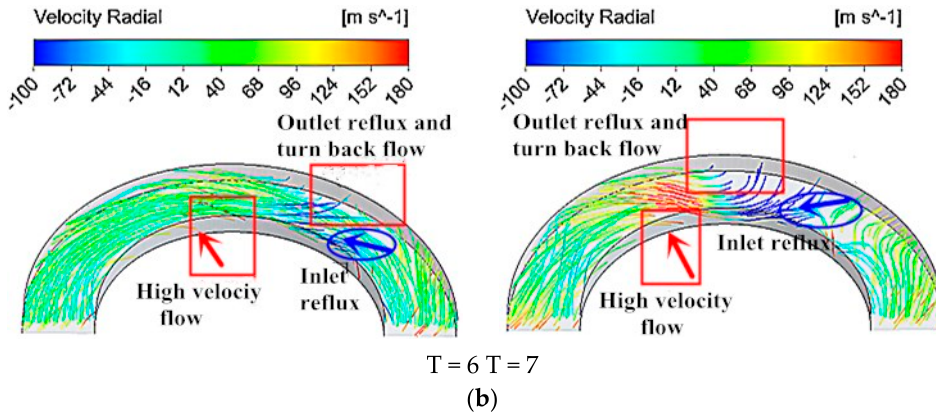
Figure 21. The streamline of vaneless diffusers with different radius ratios: ( a ) the streamline of a vaneless diffuser with a radius ratio of 1.8; ( b ) the streamline of a vaneless diffuser with a radius ratio of 1.5.